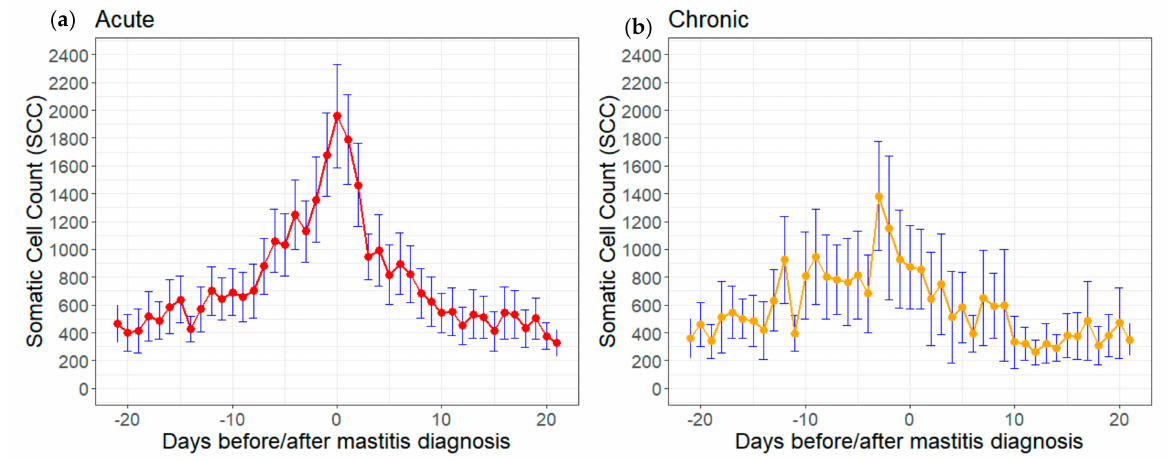
Figure 1. Daily trend of means and 95% confidence intervals of somatic cell count (SCC) in the time period 21 days before and after diagnosis of ( a ) acute or ( b ) chronic clinical mastitis diagnoses.